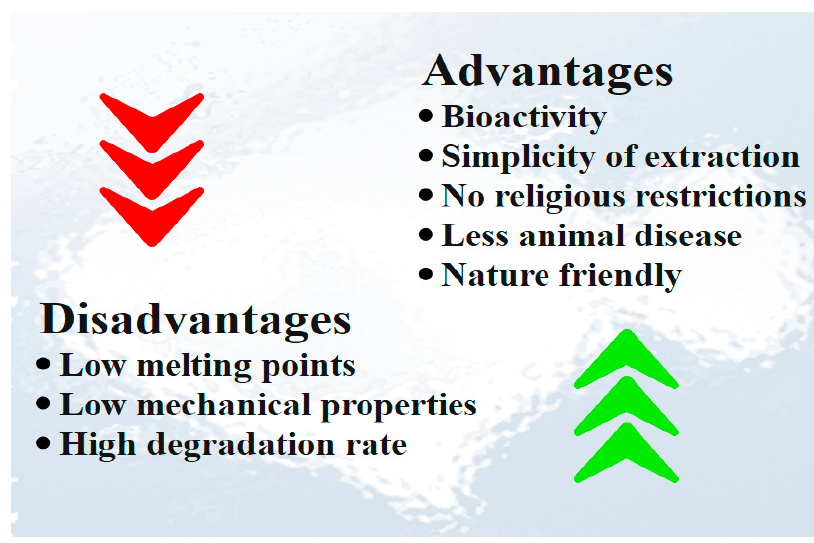
Figure 6. Advantages and disadvantages of fish collagen.